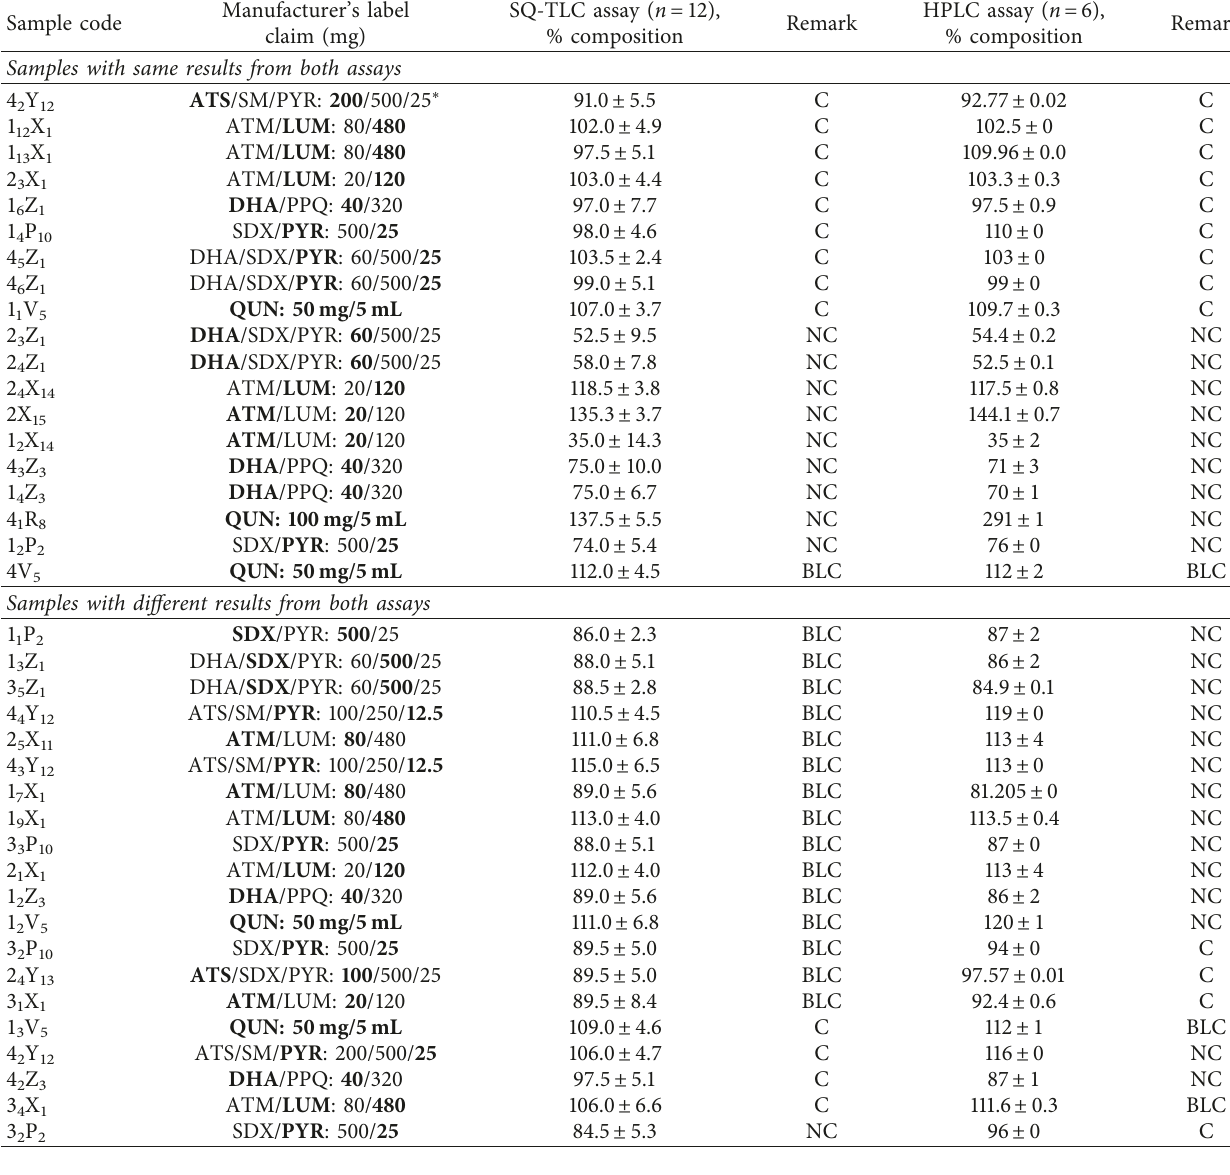
Table 3: Comparison of API content of dosage forms by SQ-TLC and HPLC methods. Sample code